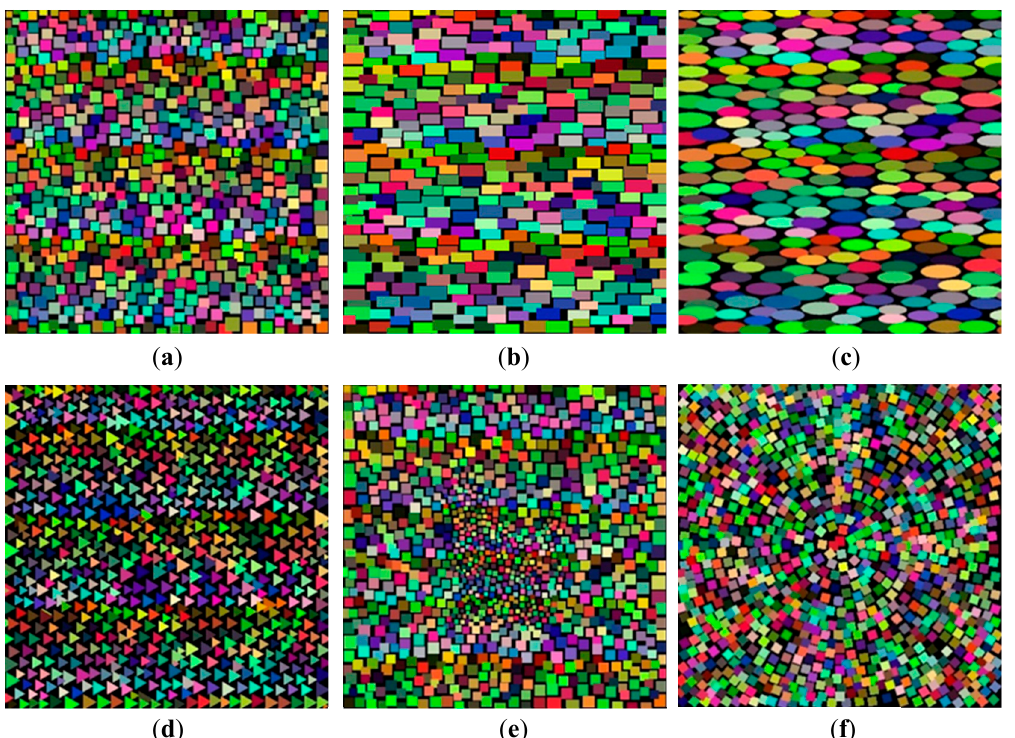
Figure 14. Demonstration of synthesis results: ( a ) distribution effects of squares; ( b ) rectangles; ( c ) ellipses; ( d ) triangles; ( e ) the distribution effects of elements with varying sizes; ( f ) the distribution